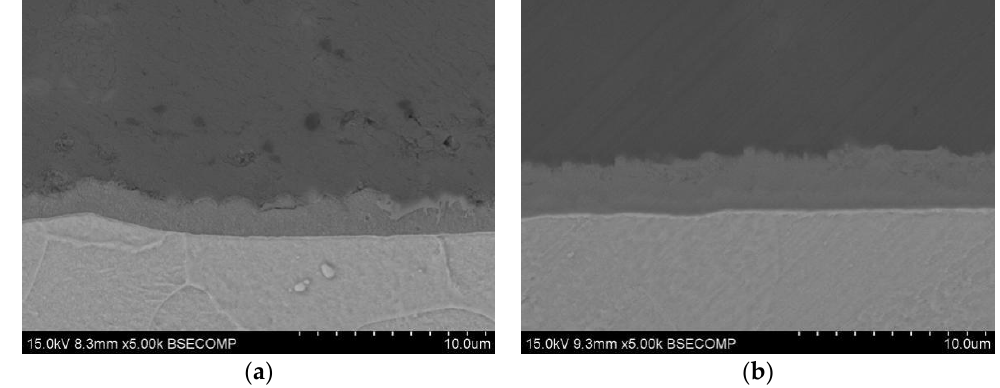
Figure 9. Microstructures of the interfacial layer at different preheating temperatures of ( a ) 100 °C; ( b ) 200 °C.